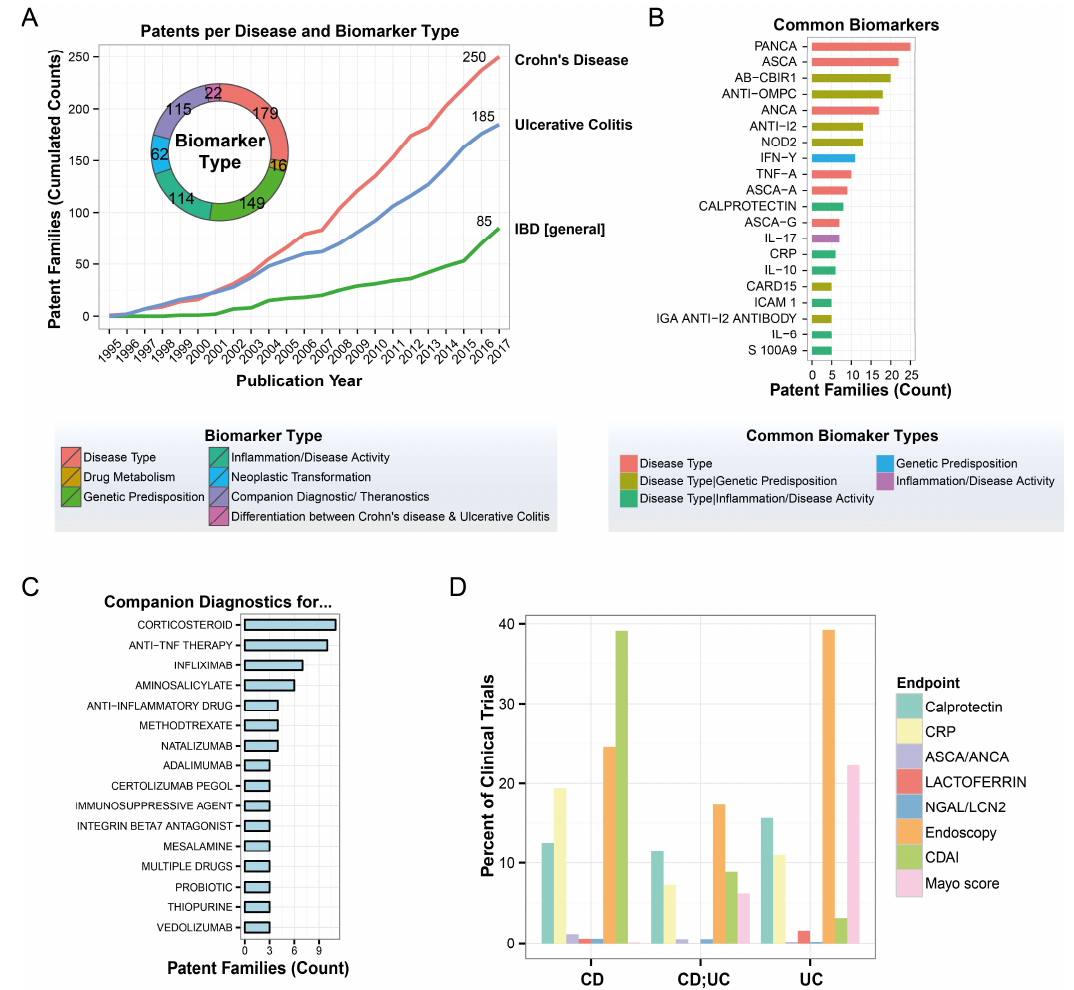
Figure 2. Patent survey for IBD biomarkers. ( A ) Development of IBD biomarker patents over the last two decades. A worldwide IBD patent search for the last 20 years was conducted by using the Questel Orbit database. Cumulative numbers of patent families for CD, UC, and general IBD over time are shown in the line chart. The donut chart shows the current breakdown of number of patents by biomarker type. Note that a patent family can be associated with more than one disease and biomarker type. ( B ) Top 20 IBD biomarker patent families. The color code shows the commonly associated disease pattern for each biomarker. Note that some biomarkers appear in different variations (e.g., ANCA (PANCA, PERINUCLEAR ANTI-NEUTROPHIL CYTOPLASMIC ANTIBODY; ANCA, ANTI-NEUTROPHIL CYTOPLASMIC ANTIBODY) and ASCA (ASCA, ANTI-SACCHAROMYCES CEREVISIAE ANTIBODY; ASCA-A, ANTI-SACCHAROMYCES CEREVISIAE ANTIBODY-IMMUNOGLOBULIN; ASCA-G, ANTI-SACCHAROMYCES CEREVISIAE ANTIBODY-IMMUNOGLOBULIN G)). ( C ) Number of patent families disclosing companion diagnostics biomarkers for IBD treatments. ( D ) Registered IBD clinical trials mentioning the respective endpoints (data regarding clinical trials on IBD downloaded from ClinicalTrials.gov on 15 December 2017; text search for different endpoints in trial title, description, and endpoint fields; trials classified as UC (512), CD (695), or both (191) were considered).